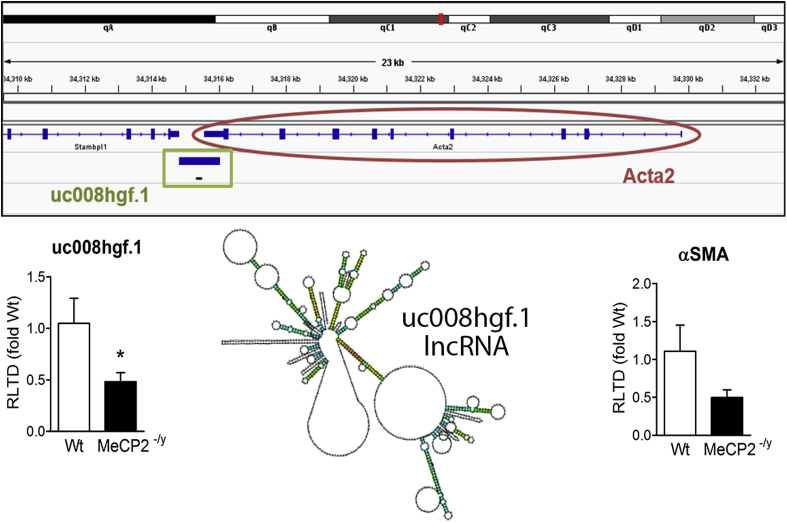
Identification/representation of the down-regulated transcript uc008hgf as in close physical association with the ACTA2 (α-SMA) locus. mRNA levels of uc008hgf.1 and α-SMA quantified by qRT-PCR to validate the results of microarray. Predicted RNA secondary structures from uc008hgf.1 lncRNA obtained with CentroidFold software using the CONTRAfold model. Error bars in relevant panels represent mean ± SEM. Statistical significance was determined by Student t test; *P < .05.